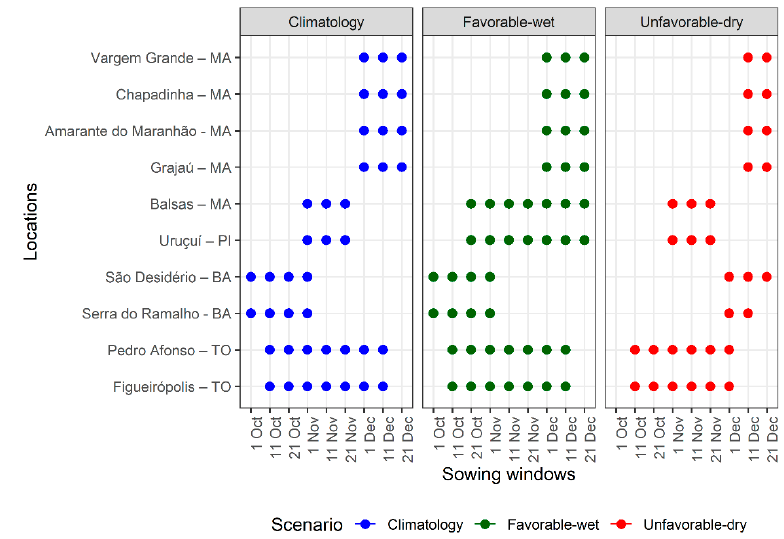
Figure 9. Best sowing windows for soybean yield in different MATOPIBA locations according to the three meteorological scenarios.